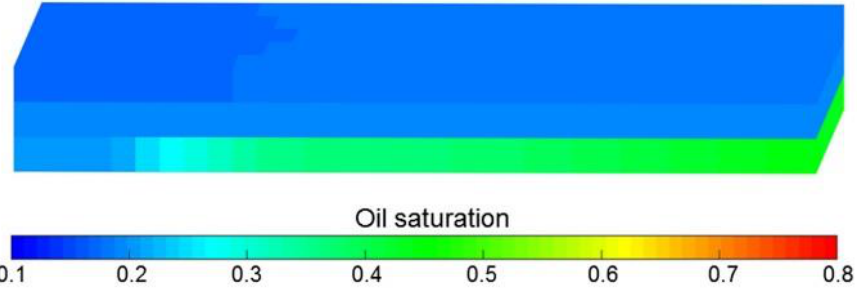
Figure 20. 3D remaining oil saturation distributions after polymer flooding of Case 16.